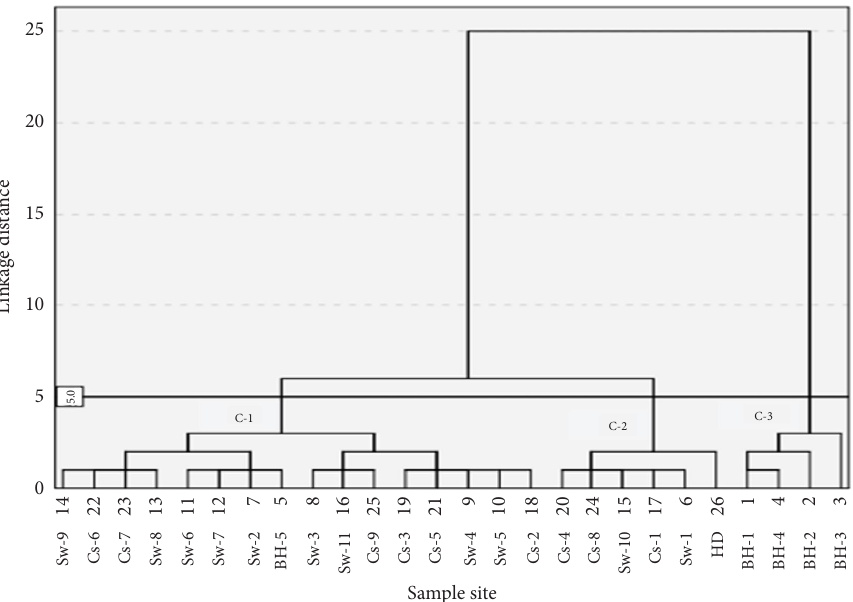
Figure 20: Hierarchical dendrogram clusters (Q-mode clustering).